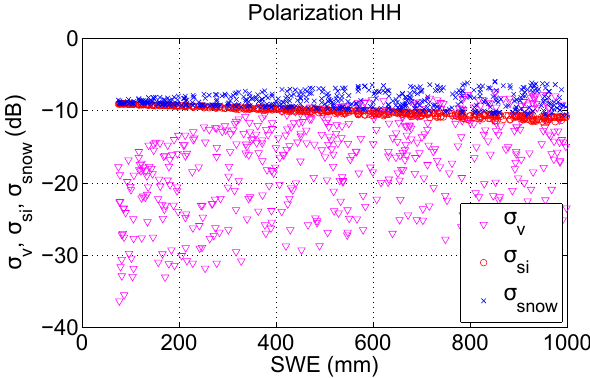
Figure 4. Test of EBM simulations on X-band, HH polarization for varying snow depth and density: snow density 200–600kgm − 3 , op- tical diameter 1mm, and snow depth 30–400cm. The glacier rough- ness is fixed at σ si = 0.9cm and l si =